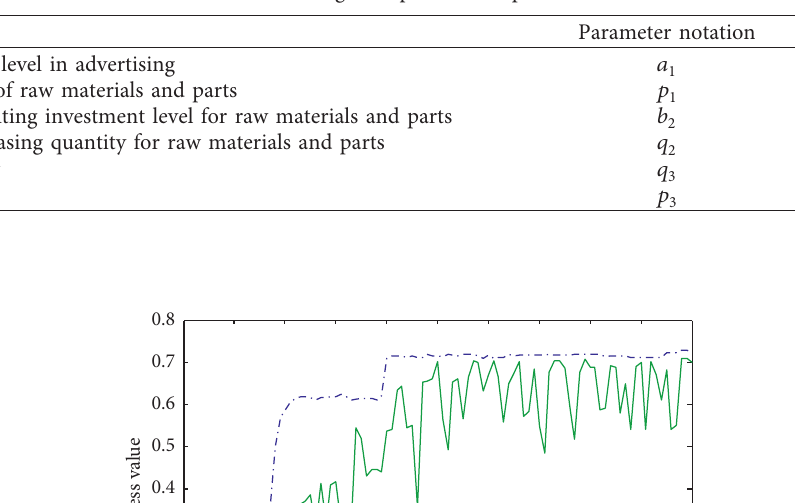
Table 3: Range of optimization parameters.